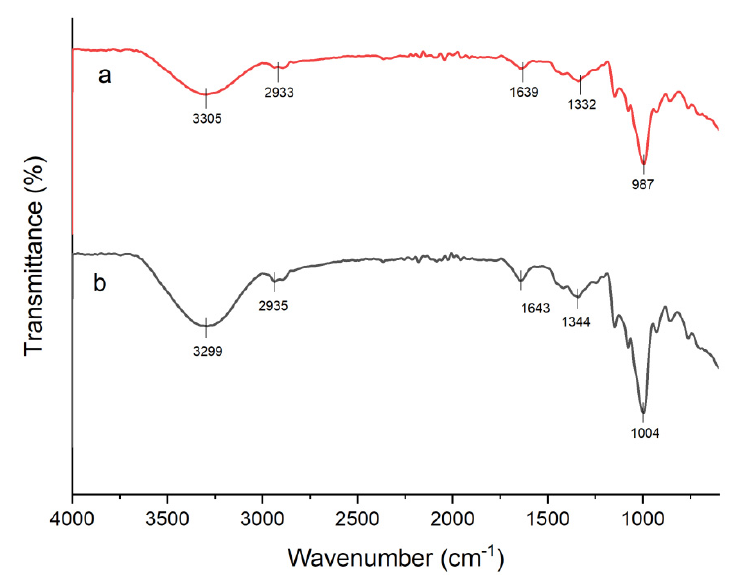
Figure 1. FT-IR spectra of ( a ) native sago starch and ( b ) native agar.